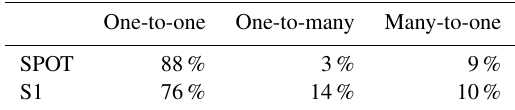
Table 5. Percentage of validation points where the specified joins were applied for the SPOT and S1 mapping. For each method only the avalanches mapped and validated (true positives) were consid-